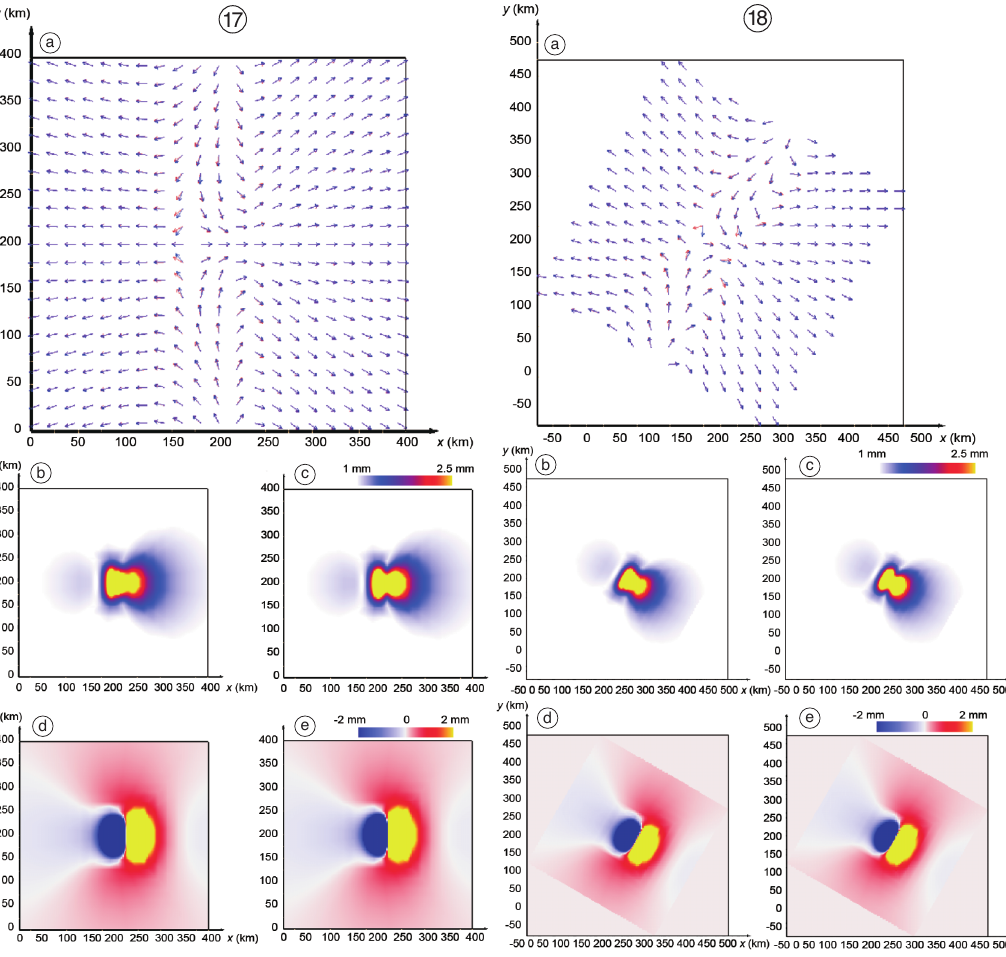
Fig. 17a-e. Same as fig. 11a-e but for a normal dip slip with δ = 20° and φ = 0°. Fig. 18a-e. Same as fig. 11a-e but for a normal dip slip with δ = 20° and φ =